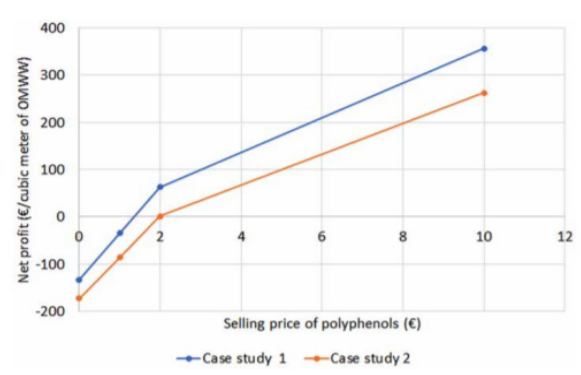
Figure 16. Net profit as a function of selling price for polyphenols [232].